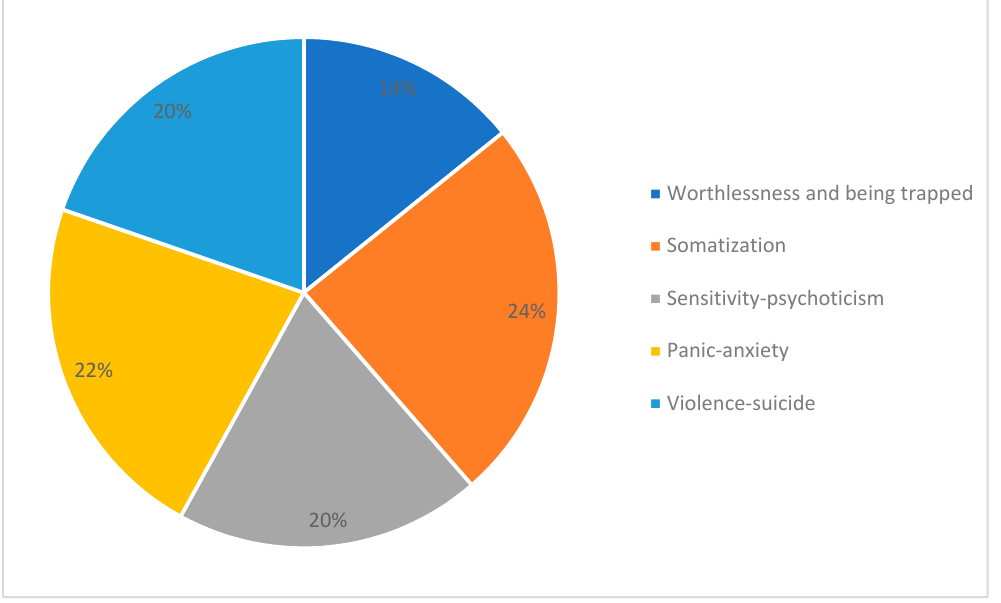
Figure 1. Patients assigned to psychopathologically dominant groups according to Z-scores for each of the five clusters obtained by the exploratory principal component factor analysis (PCA) applied to 1055 SCL-90 questionnaires filled in by patients with opioid dependence at the time they started to take opioid agonist medications [14].